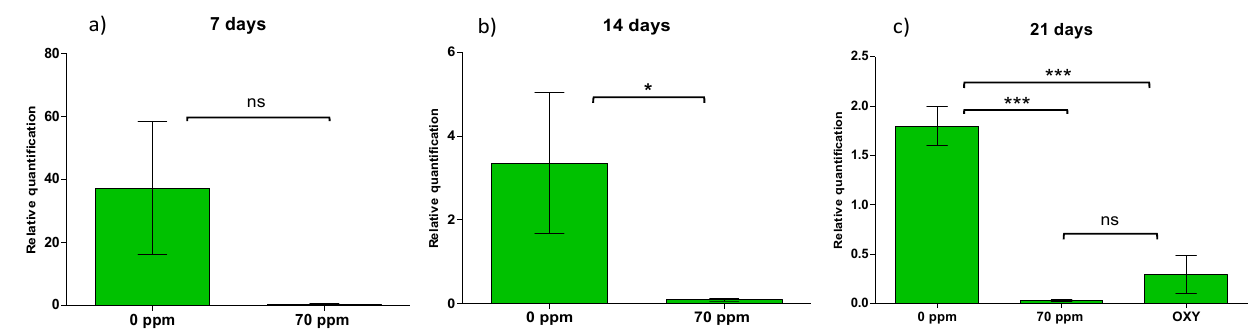
Figure 4. Quantification of the Candidatus Liberibacter solanacearum ( Ca Lso) in tomato leaves ( Solanum lycopersicum ) at ( a ) 7 days, ( b ) 14 days, and ( c ) 21 days post-treatment with 70 ppm of PNB using qPCR. Response to treatment with oxytetracycline (OXY) is shown in ( c ). Values are means ± SE ( n = 6); Level of significance: *, p < 0.05; ***, p < 0.001; ns, not significant. One-way ANOVA test at p ≤